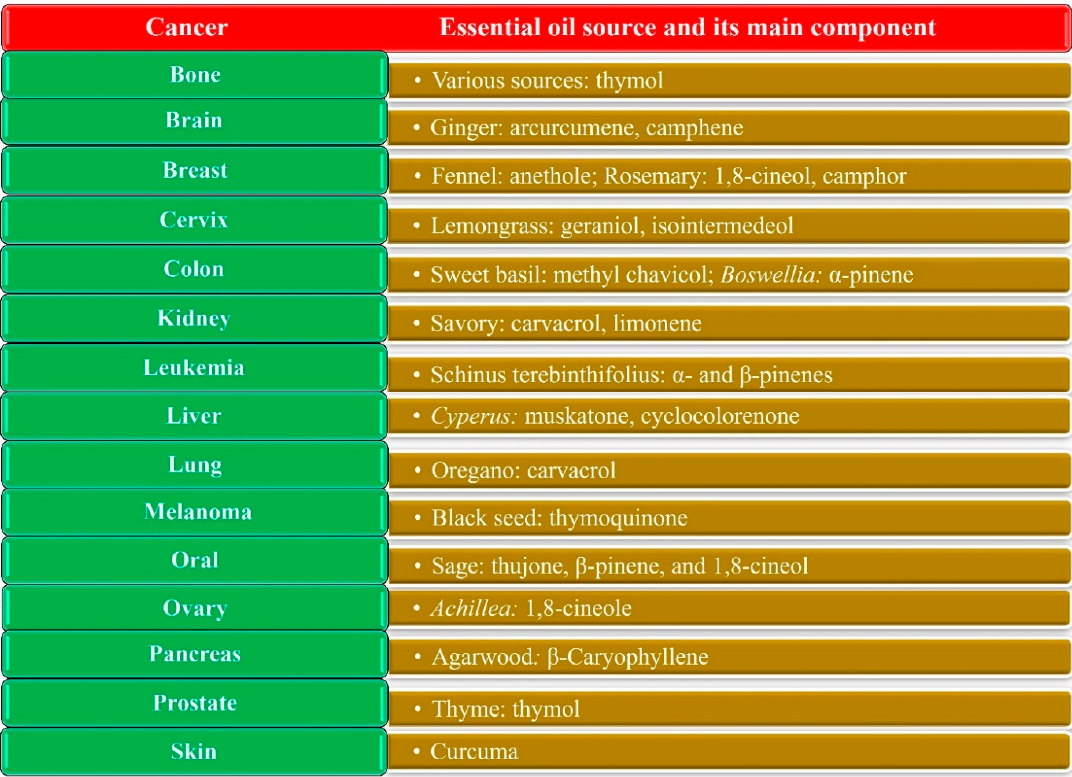
Figure 4. Examples of EOs with anticancer effects in cancers of the brain [74], colon [75,76], breast [77,78], skin (melanoma) [79,80], blood (leukemia) [81,82], oral tissues [83,84], bone [85], cervix [86], lung [87], prostate [88], kidney [89], liver [90], ovary [91], and pancreas [92].